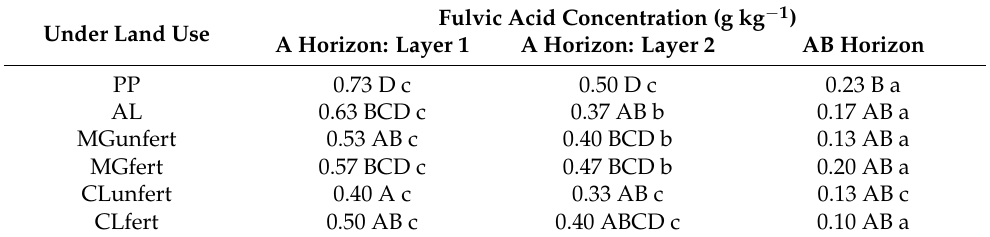
Table 6. Concentration of fulvic acids (g kg − 1 ) in different layers of soil of different land uses. Fulvic Acid Concentration (g kg − 1 ) Under Land Use A Horizon: Layer 1 A Horizon: Layer 2